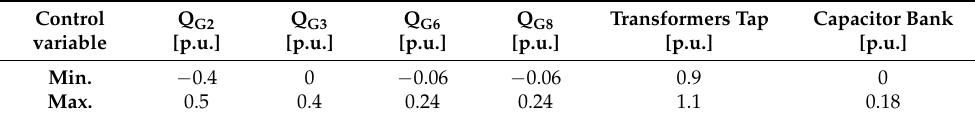
Table 3. Control variables limits for IEEE 14-bus